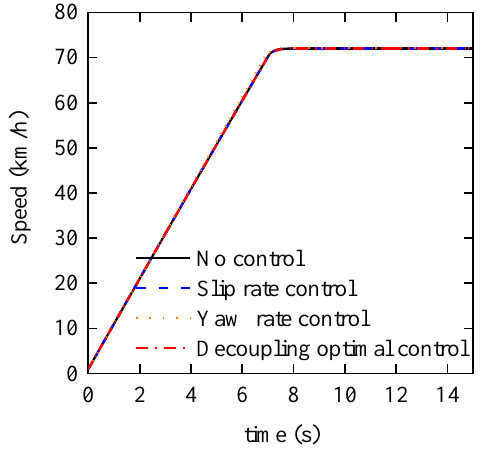
Figure 9. Vehicle speed.